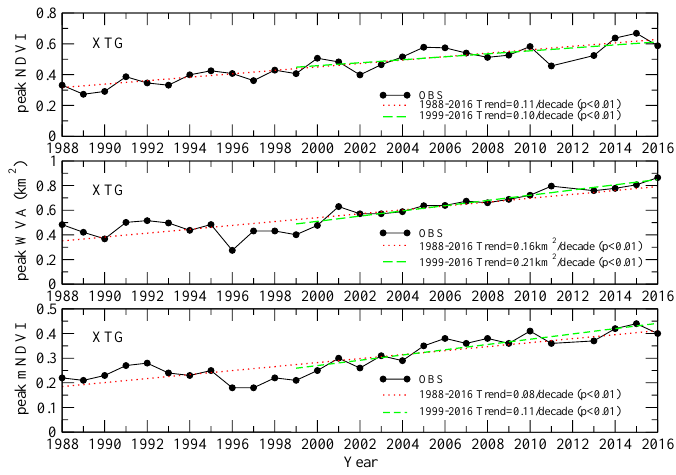
Figure 11. The time series plots and trends of peak NDVI at the XTG’s typical wetland vegetation pixel ( top ), the peak wetland vegetated area ( center ), and the peak spatial mean NDVI ( bottom ) in the XTG.